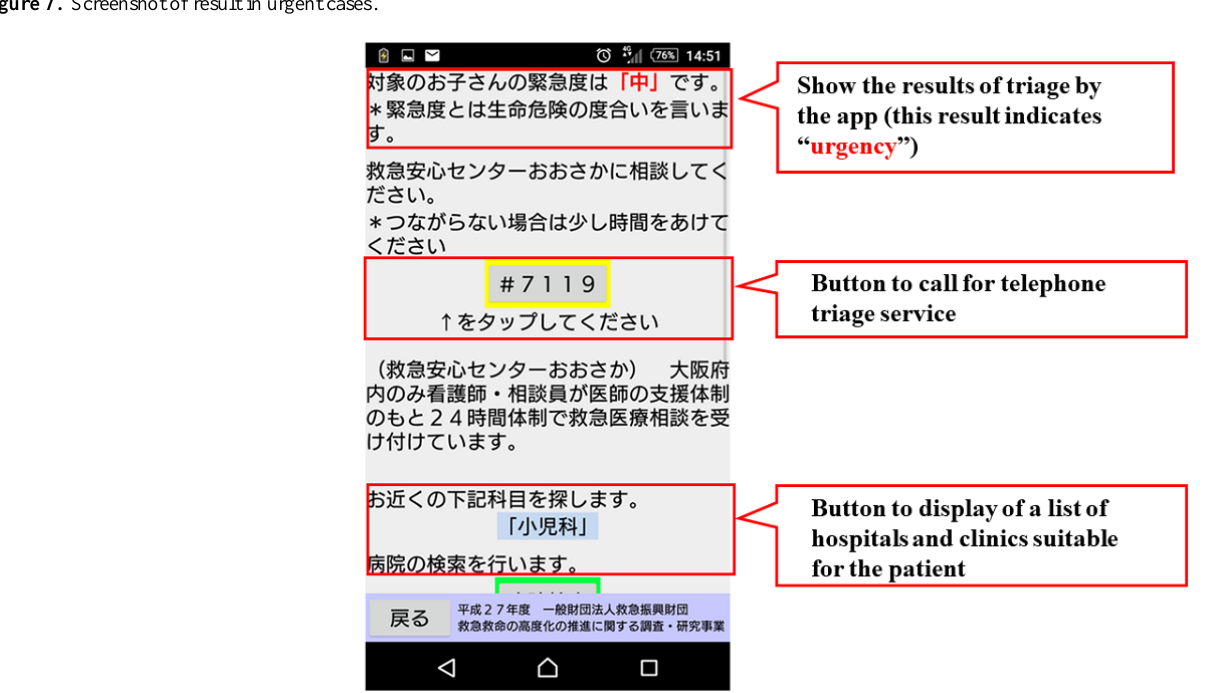
Figure 7. Screenshot of result in urgent